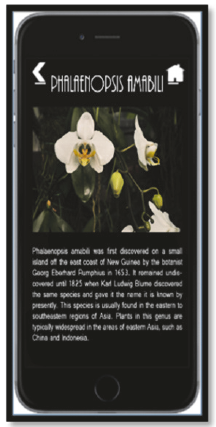
Figure 3: Kuching Orchid Garden with points of interest markers.